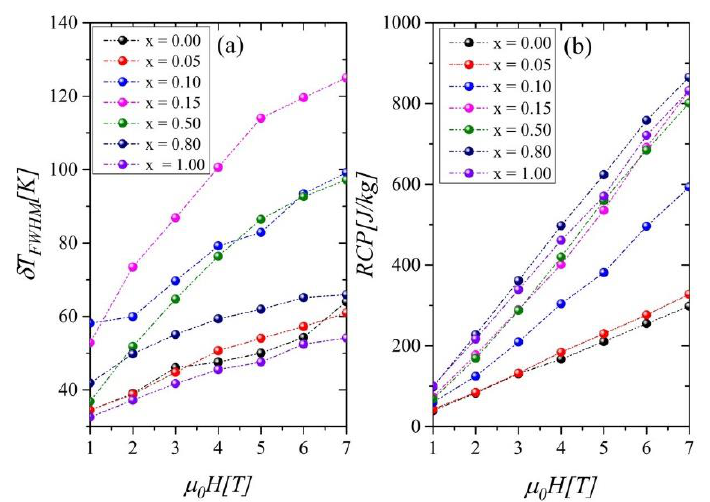
Figure 10. Operating temperatures δT FWHM ( a ) and RCP parameters as a function of a magnetic field ( b ).